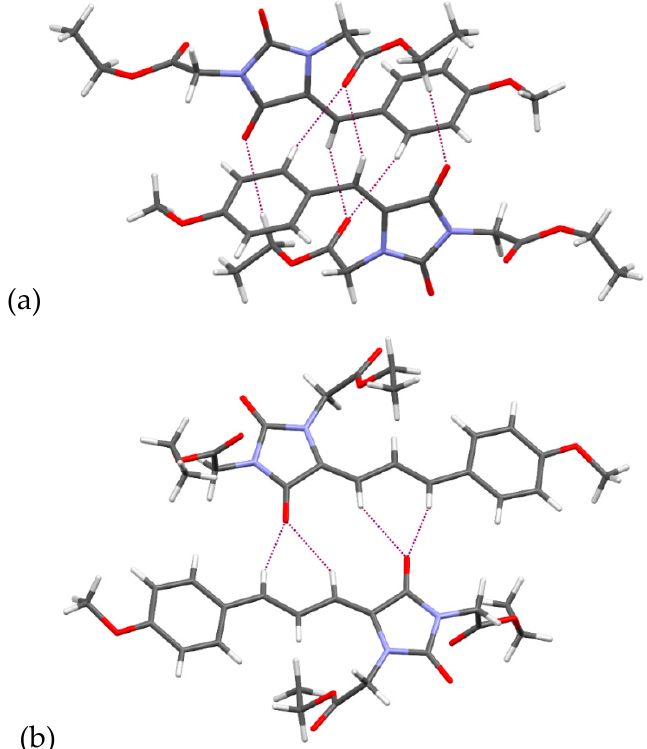
Figure 3. The intermolecular interactions of two molecules of ( a ) 3b and ( b ) 4g . Dashed lines indicates hydrogen bonds. The disordered fragment of 3b is depicted only for major occupancy.